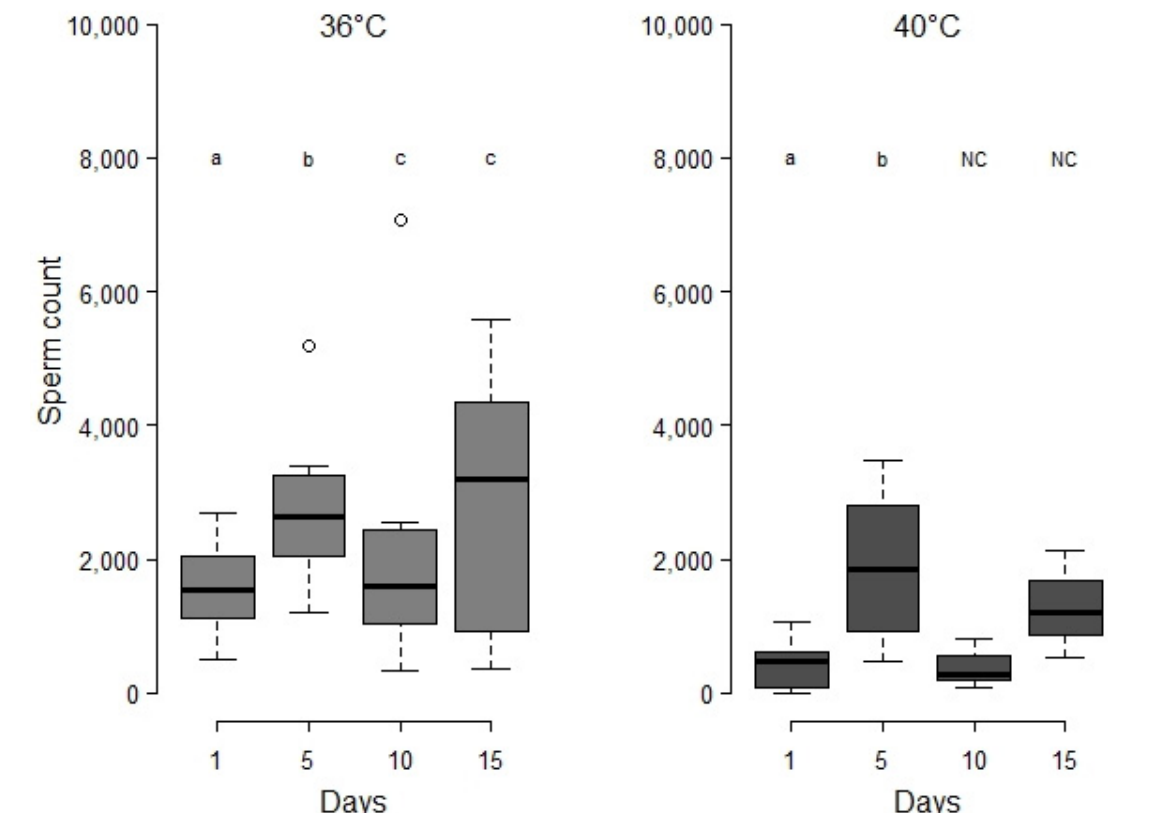
Figure 5. Evolution of M. rufiventris male sperm stock in seminal vesicles after a 24 h heat period at white pupal stage. Series of virgin males were considered respectively at 1, 5, 10, and 15 days. Number of males are for 36 °C respectively n = 14; 14; 10; 11 and for 40 °C n = 14; 10; 3; 3. Kruskal–Wallis tests: for 36 °C, Chi² = 8.8, df = 3, p < 0.05; for 40 °C, Chi² = 15.3, df = 3, p < 0.01. Letters indicate series that are statistically different from the previous one (Wilcoxon test, p < 0.05); for 40 °C, data at 10 and 15 days do not meet Wilcoxon test requirements of n > 5 (NC).